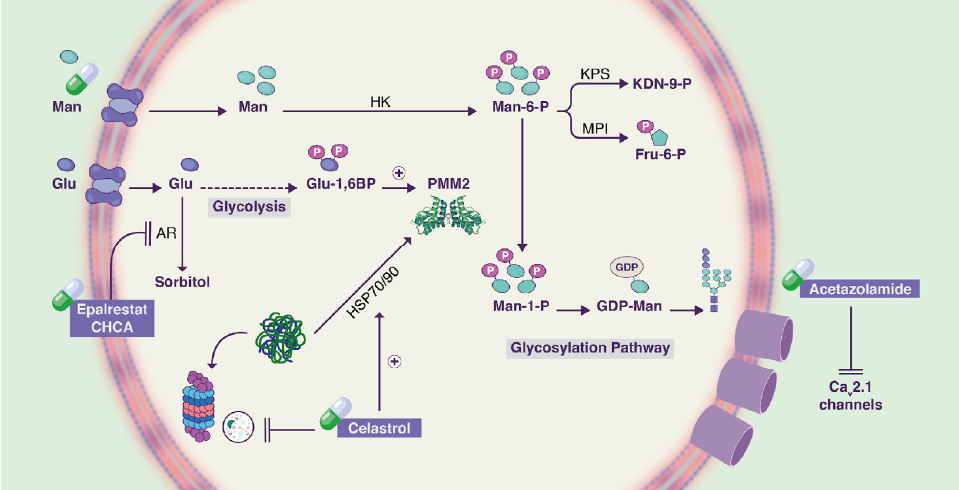
Figure 3. Schematic representation of the mechanism of action of drugs under testing in clinical trials for PMM2-CDG. Acetazolamide inhibits CaV2.1 calcium channels. Epalrestat inhibits sorbitol synthesis. Celastrol modulates PMM2 proteostasis. Adapted from Gámez et al., 2020 [85].